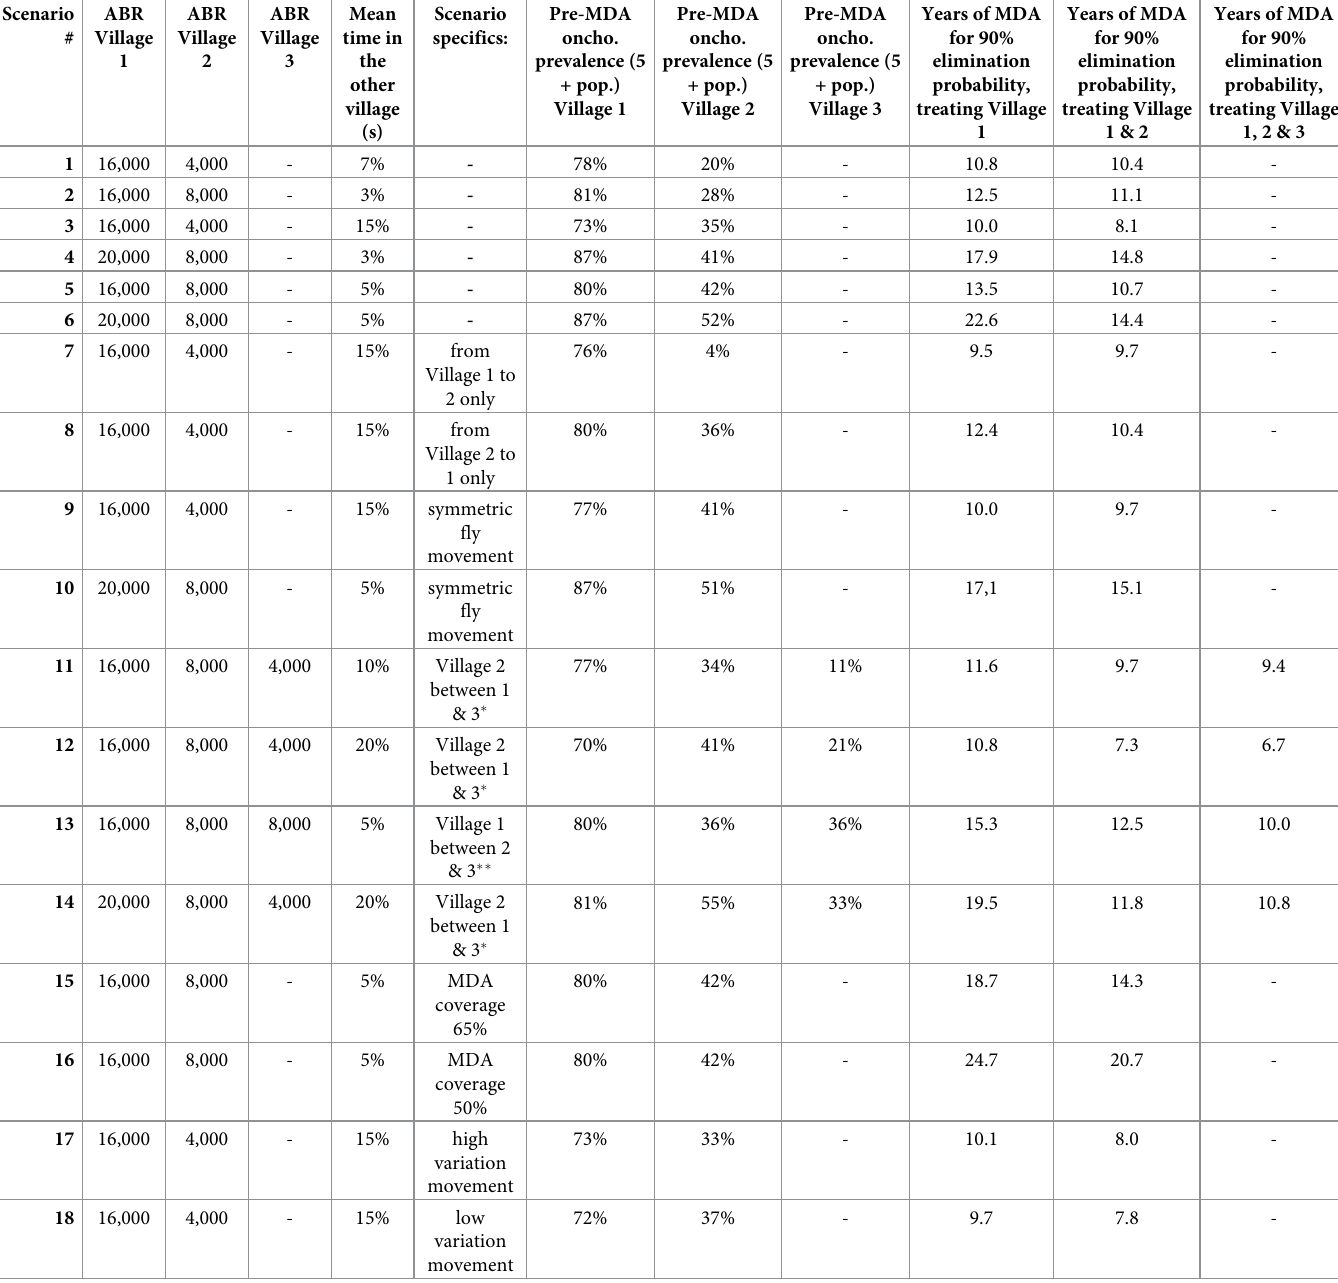
Table 1. Impact of MDA implementation strategies, for different geographical settings. Scenario